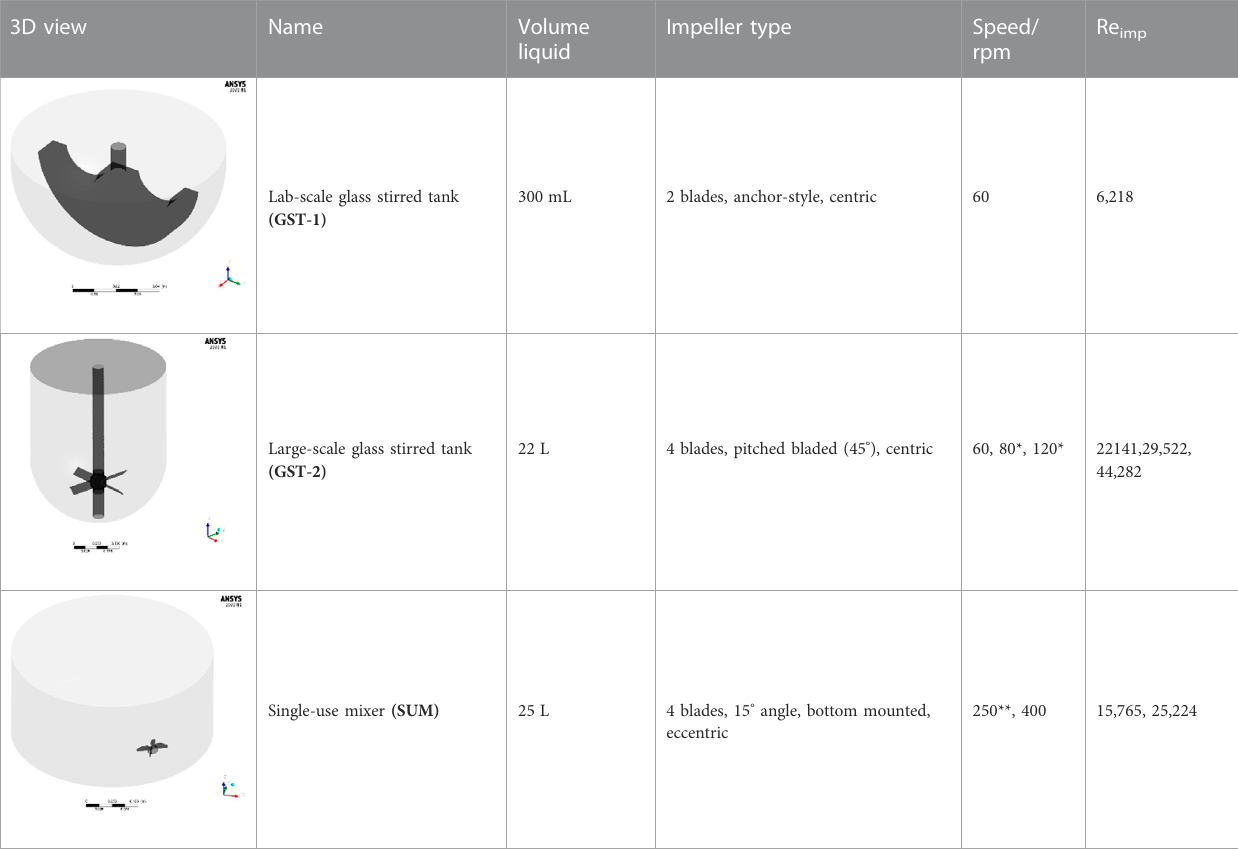
TABLE 1 Geometries and parameters of the studied reaction vessels. *For GST-2, three stirrer speeds were investigated in the parameter study. **For the SUM a lower stirrer speed of 250 rpm was added because mixing time data were available only for this stirrer speed. 3D